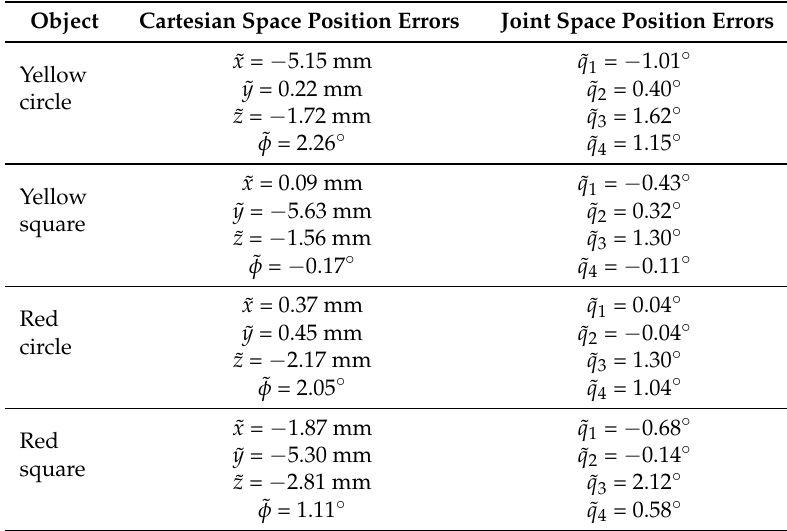
Table 5. Errors at the instant when the object is taken by the robot.